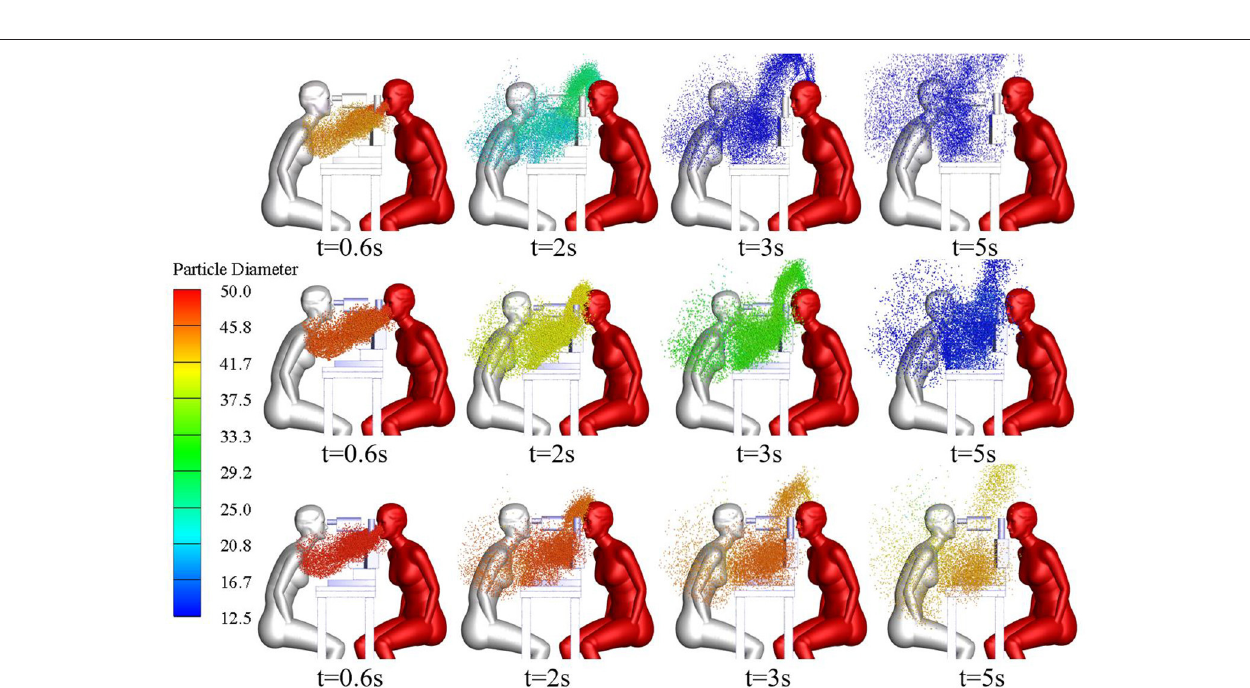
FIGURE 7 | Comparison of cloud images of droplet-size distribution when the RH is 40, 70, or